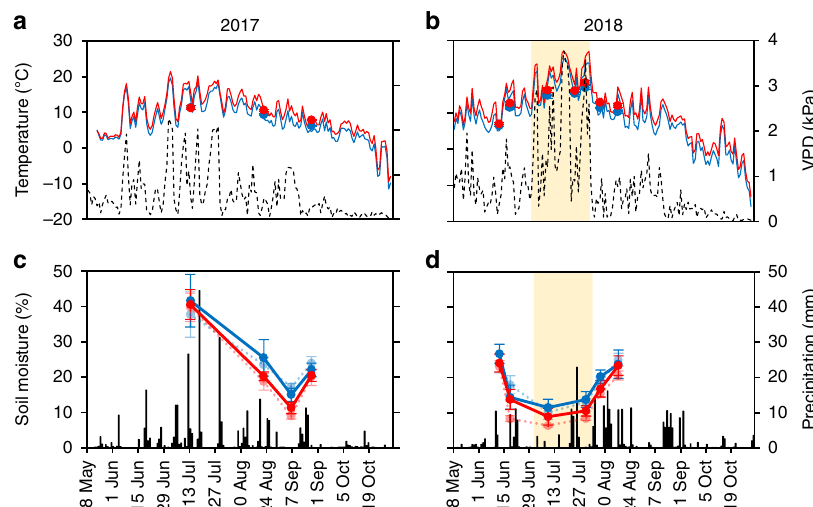
Fig. 3 Abiotic attributes during periods of warming in 2017 and 2018. a , b Air temperature (solid lines are mean daily temperatures of warmed [red] and ambient [blue] plots, n = 3 fi eld plots), soil temperature (dots are mean ± s.e.m. of warmed [red] and ambient [blue] plots, n = 10 fi eld plots, each examined through 3 – 5 within-plot measurements) and daily maximum of atmospheric water vapor pressure de fi cit (VPD; dashed black line); c , d soil moisture (dots are means ± s.e.m. of warmed [red] and ambient [blue] plots, light tone dashed lines and symbols denote plots, where herbivory was reduced using insecticide; n = 5 fi eld plots, each examined through 3 – 5 within-plot measurements) and daily precipitation (thin black bars). Precipitation and VPD data are from the Kevo weather station (Finnish Meteorological Institute), located 200 m from the experimental site. The pale yellow background stripe stands for the period of severe hydrological stress (2nd July – 1st August, 2018). Source data are provided as a Source Data fi